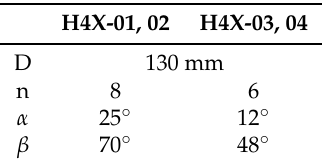
Table 6. Parameters of two fuel grain geometries of HYDRA 4X.